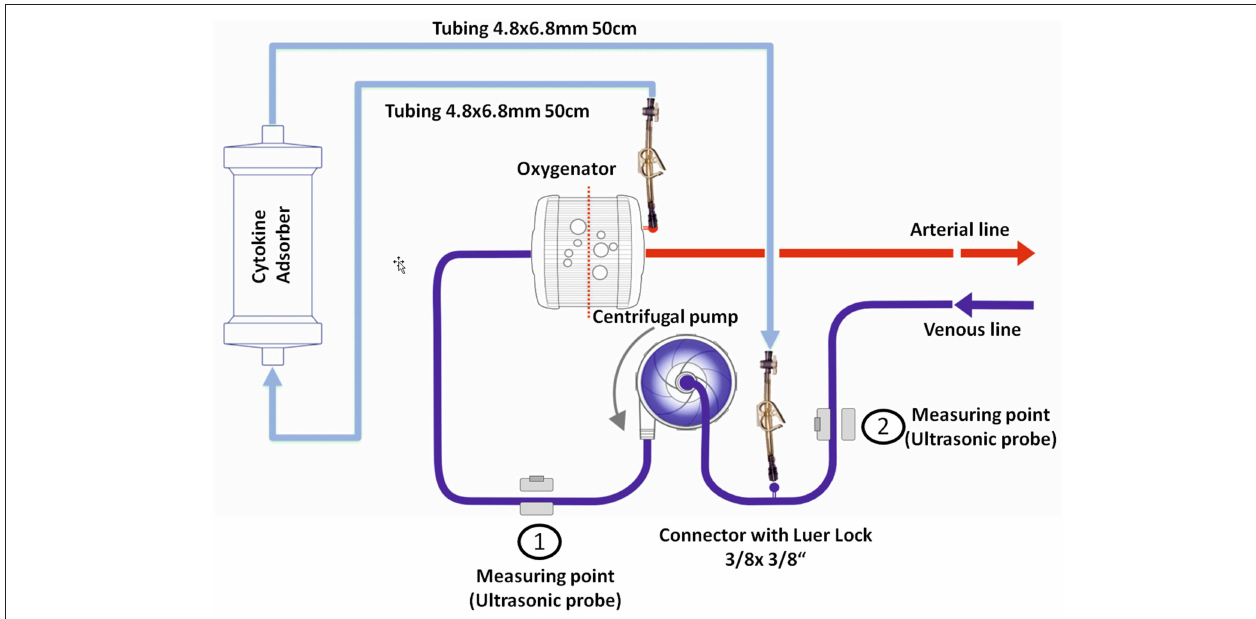
FIGURE 1 | Technical implementation of the cytokine adsorber into the ECMO circuit. The CytoSorb adsorber was connected in parallel, placed at the arterial oxygenator outlet via an 3-way stop-cock and was returned into the venous line before the centrifugal pump. Blood flow was measured before and after the 3-way stop-cock in the venous